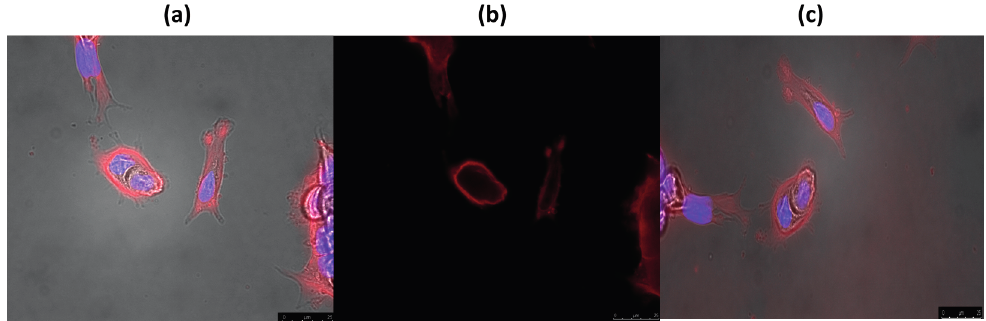
Figure 8. Fluorescence images of the interaction between phthalocyanine 12 (50.0 µM final concentration) and MCF7 cells ( a , b ). The images were produced by 365 nm excitation, using 420 nm (DAPI) and 590 nm (phthalocyanine) emission filter. DAPI was used to following the studied phthalocyanine (red fluorescence) according to the nuclei position. ( c ) Presents the same phthalocyanine cell interaction after 10 min of red light irradiation (660 nm, 8 W/cm 2 ).